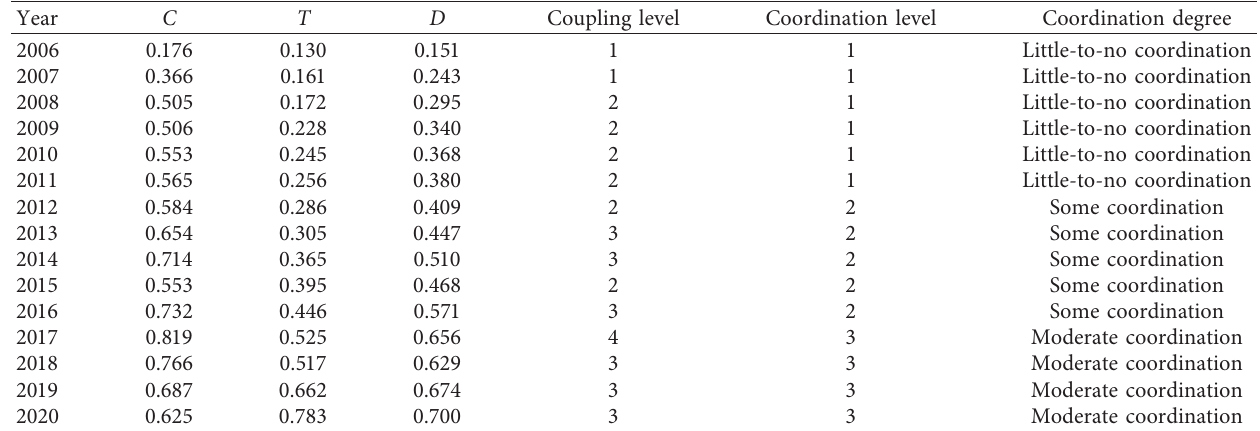
Table 4: Calculation results of coupling